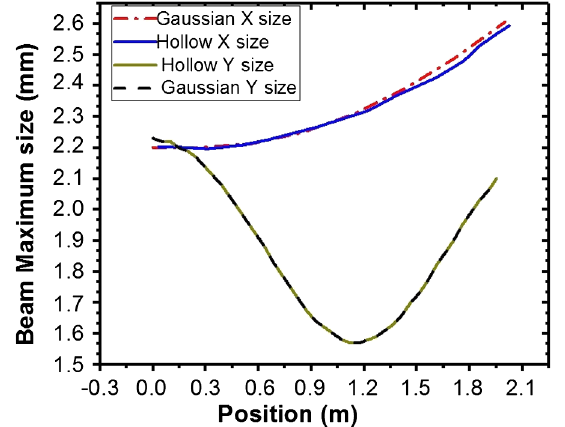
m.FIG. 3. Variation of the transverse size of the electron beam along the undulator for λ ¼ 10 μ m for Gaussian and hollow